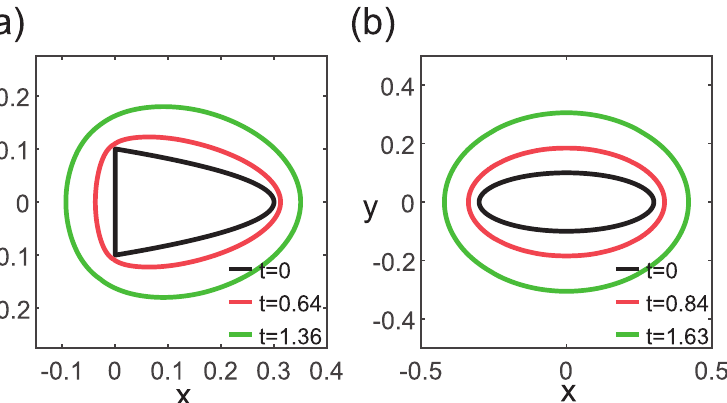
Fig 2. Dynamics of cluster growth without growth regulation. Cluster is initialized as (a) a parabolic cluster and (b) an elliptical cluster. As all cells grow at the same rate, an initial elongated cluster (black lines) becomes increasingly circular over time (black to pink to